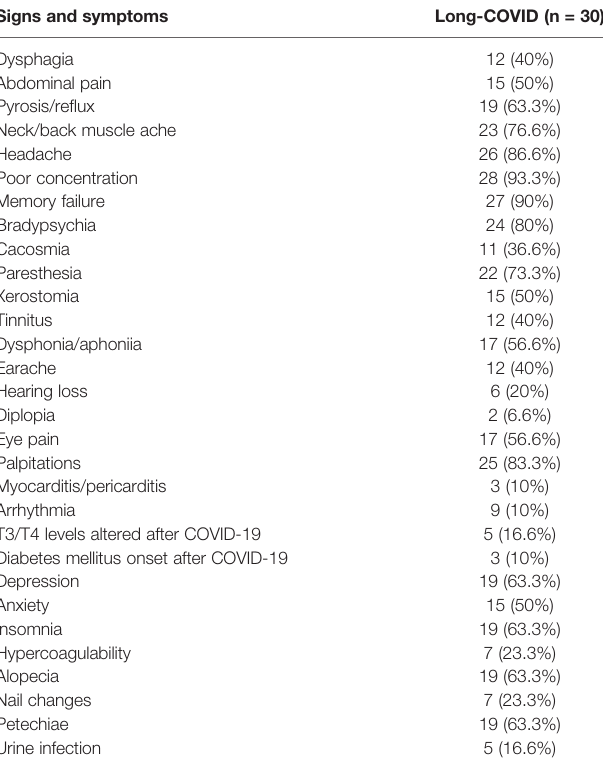
TABLE 2 | Clinical signs and symptoms reported by the participants from the Long-COVID group recruited for this